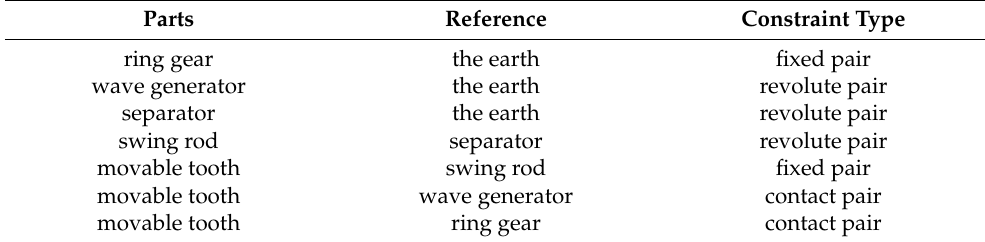
Figure 6. Virtual prototype simulation model. Table 2. Constraints of each